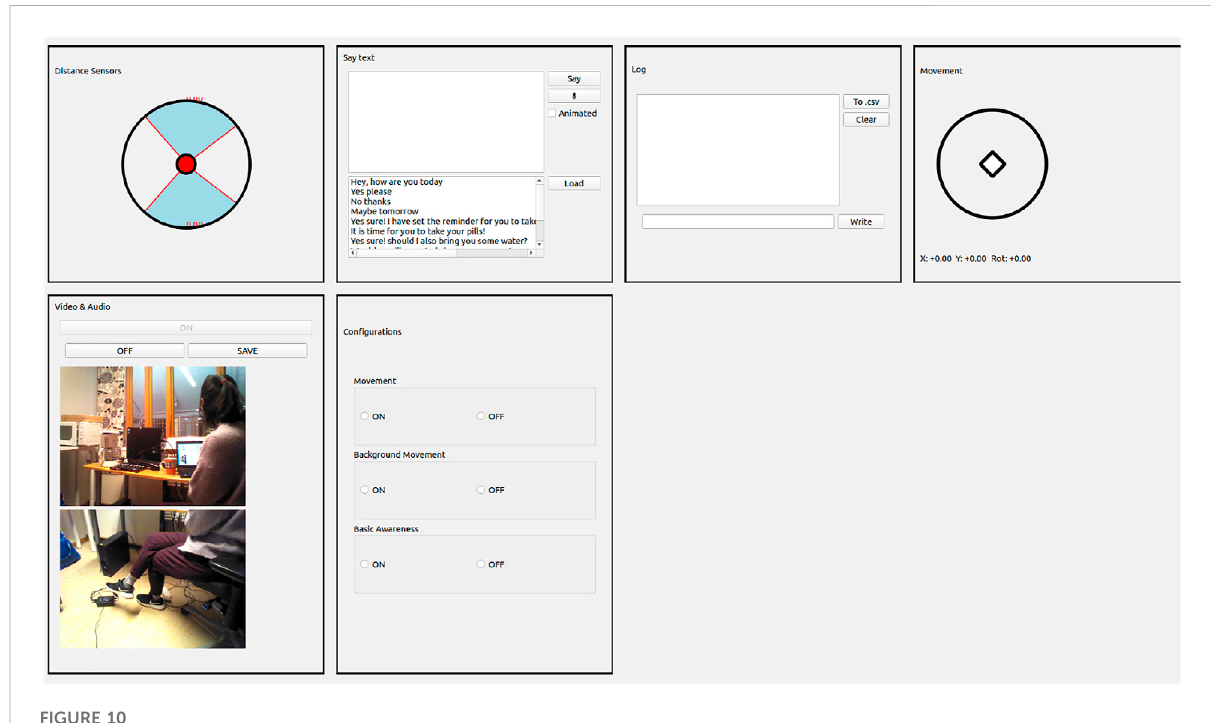
FIGURE 10 WoZ interface for operating the Nao robot remotely during the interactions.